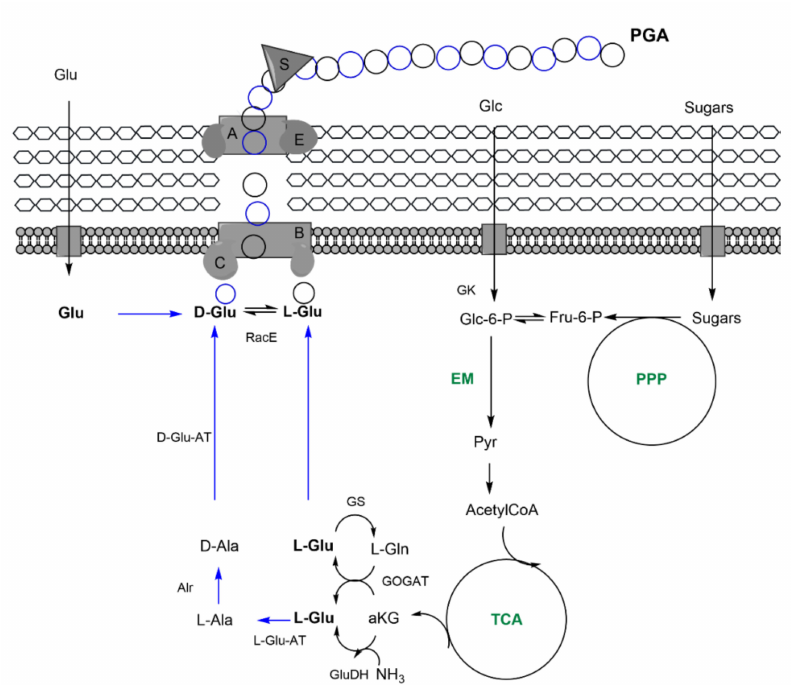
Figure 4. Metabolic network of PGA metabolism in model bacteria B. subtilis 168. Exogenous glu can serve as a direct precursor of PGA synthesis. Alternatively, sugars are metabolized via the Embden Meyerhof (EM) pathway, PPP and TCA. α KG from TCA is then converted to L-glu (the PGA monomer) by two different enzymes—glutamine oxoglutarate aminotransferase (GOGAT), which transfers the amino group from a glutamine molecule, and Glu dehydrogenase (GluDH), which incorporates the amino group from an ammonium molecule. In the species producing L/D-PGA (such as B. subtilis ), a racemization reaction to produce the D-isomer takes place. This can be produced by means of two different enzymatic reactions: the Glu racemase (RacE) directly interconverting the isomers and a 3-enzymatic-step reaction by L-glu-pyruvate aminotrasnferase (L-Glu-AT), alanine racemase (Alr), and D-glu-pyruvate aminotransferase (D-Glu-AT). D/L glu monomers are then polymerized in the active site formed by membrane-bound PgsB (B) and PgsC (C), and the elongated chain is then removed from the active site by PgsA (A). The role of PgsE (E) is still under debate, while PgdS (S) is a secreted peptidase that releases the PGA to the medium. The main metabolic pathways, TCA, GNG, and PPP, are indicated in green. The pathway leading to PGA synthesis is indicated in blue. Key enzymes, glucokinase (GK), GOGAT, GluDH, glutamine synthetase (GS), L-Glu-AT, Alr, D-Glu-AT, and RacE are